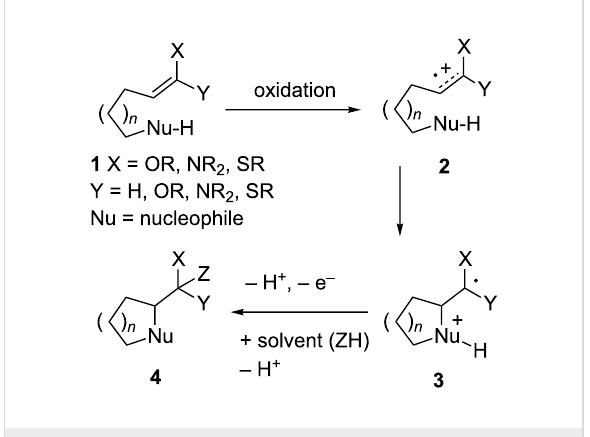
Scheme 1: General scheme for anodic cyclization